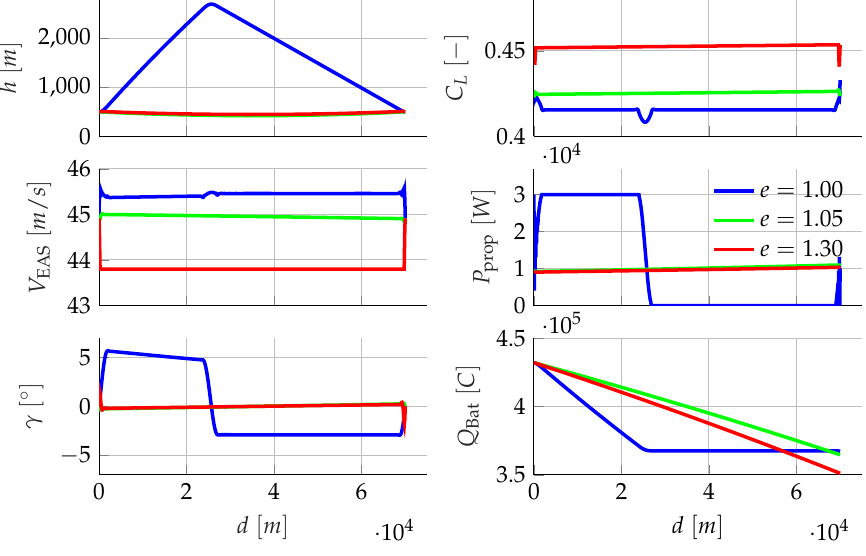
Figure 2. Optimal Trajectories for e = [ 1.00,1.05,1.30 ]